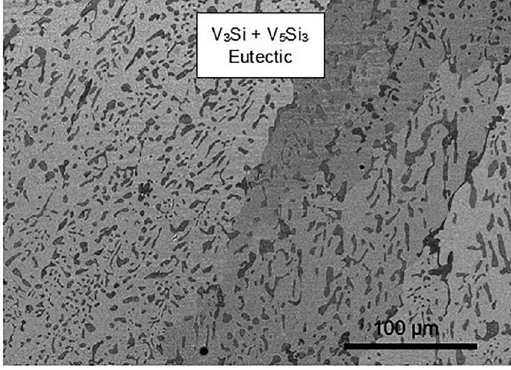
Figure 3: SEM/BSE micrograph of the V27.6Si as-cast alloy. The XRD results of V37.2Si alloy have indicated